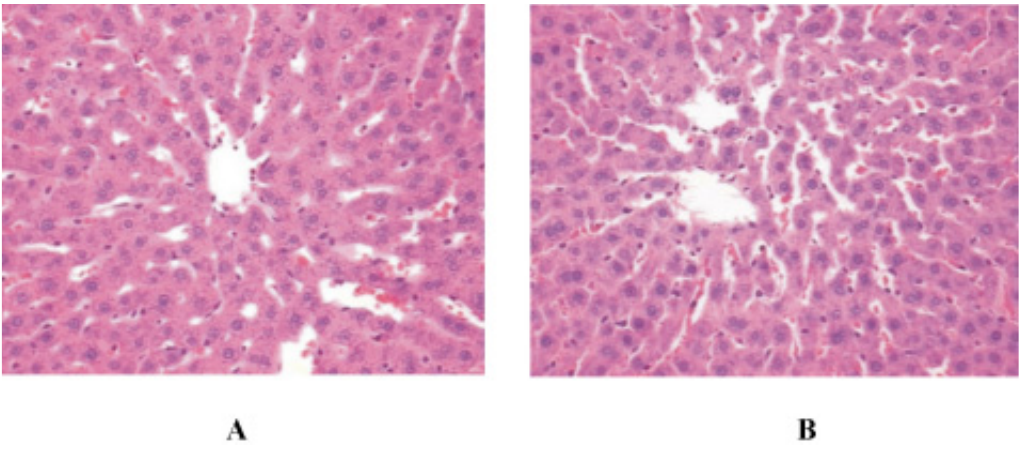
FIGURE 3 – A. Hepatic micrograph of control group. B. Hepatic micrograph of group treated with 100mg/Kg of Equisetum arvense